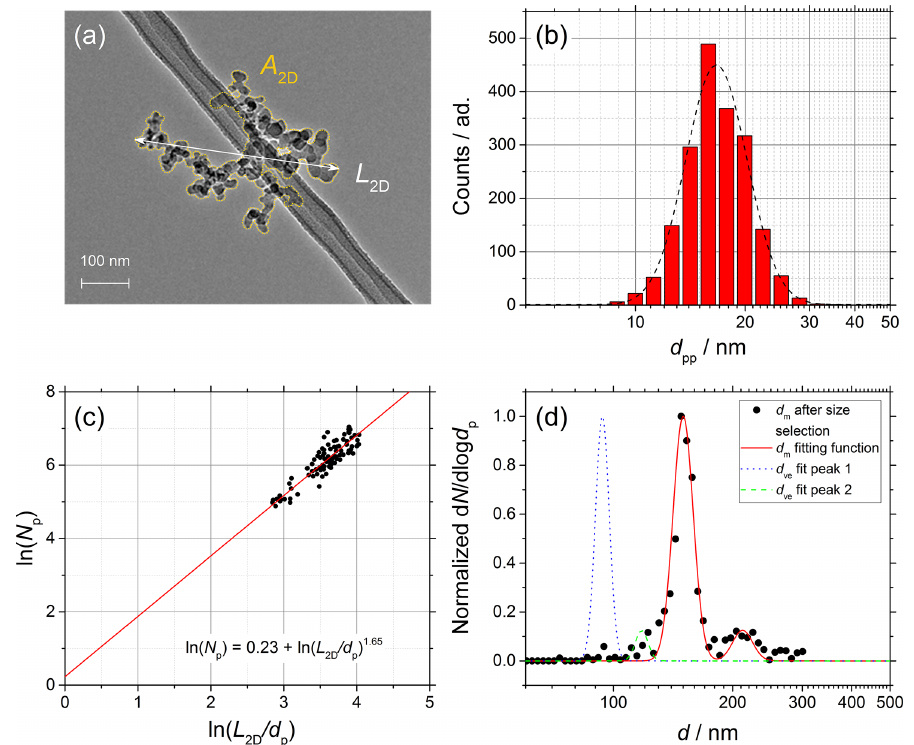
Figure 6. Soot sampled from the turbulent jet flame supplied with liquid kerosene at 130mm HAB. (a) TEM picture of a soot aggregate showing L 2D and A 2D . (b) d pp size distribution (red bars) and lognormal fit (dashed black line), d pp = 16 . 7nm (mass equivalent d pp = 17 . 7nm). (c) ln (N pp ) vs. ln (L 2D /d pp ) plot from which D f is obtained (100 projections). (d) Normalized SMPS data and d m fit after size selection at 150nm (black data points and dashed red line) and morphology-corrected d ve calculated using Eq. (11) showing a two-mode fit from Eq. (12) (dotted blue and dashed green lines). Table 2. Size and morphology parameters ( d pp , D f and d m ) used for calculating the morphology-corrected d ve of young (70mm HAB) and mature (130mm HAB) soot particles. Comparison with the activation data at different ozone exposure; µ κ, mode and σ κ, geo are calculated from the best fit (the variability range of µ κ, mode is provided in brackets). HAB/mm d pp / nm D f / ad. d m / nm d ve / nm Exposure/ µ κ, geo / 10 − 4 σ κ, geo / ad. (mode, TEM) (mode, SMPS) (mode) 10 16 cm − 3 s (geo. mean) (geo.